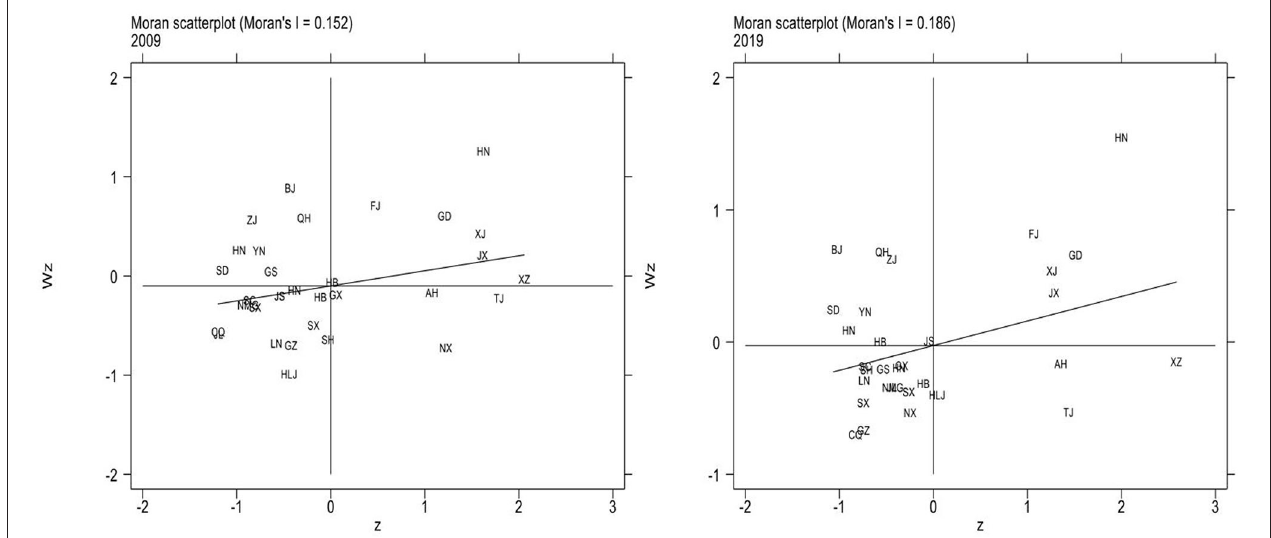
FIGURE 4 | Local Moran scatter plots in 2009 and 2019.